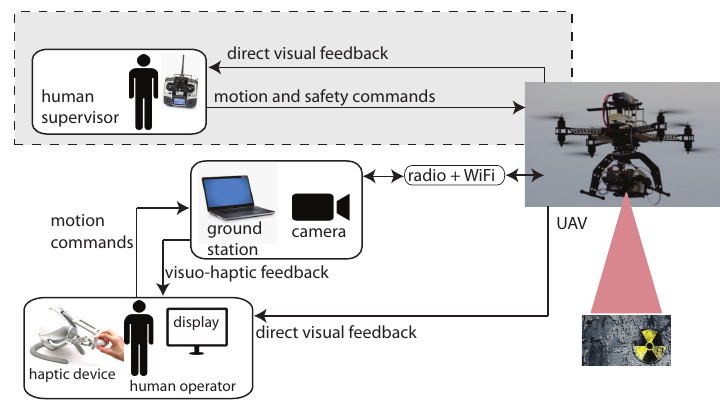
Figure 2. Overall architecture of the system.